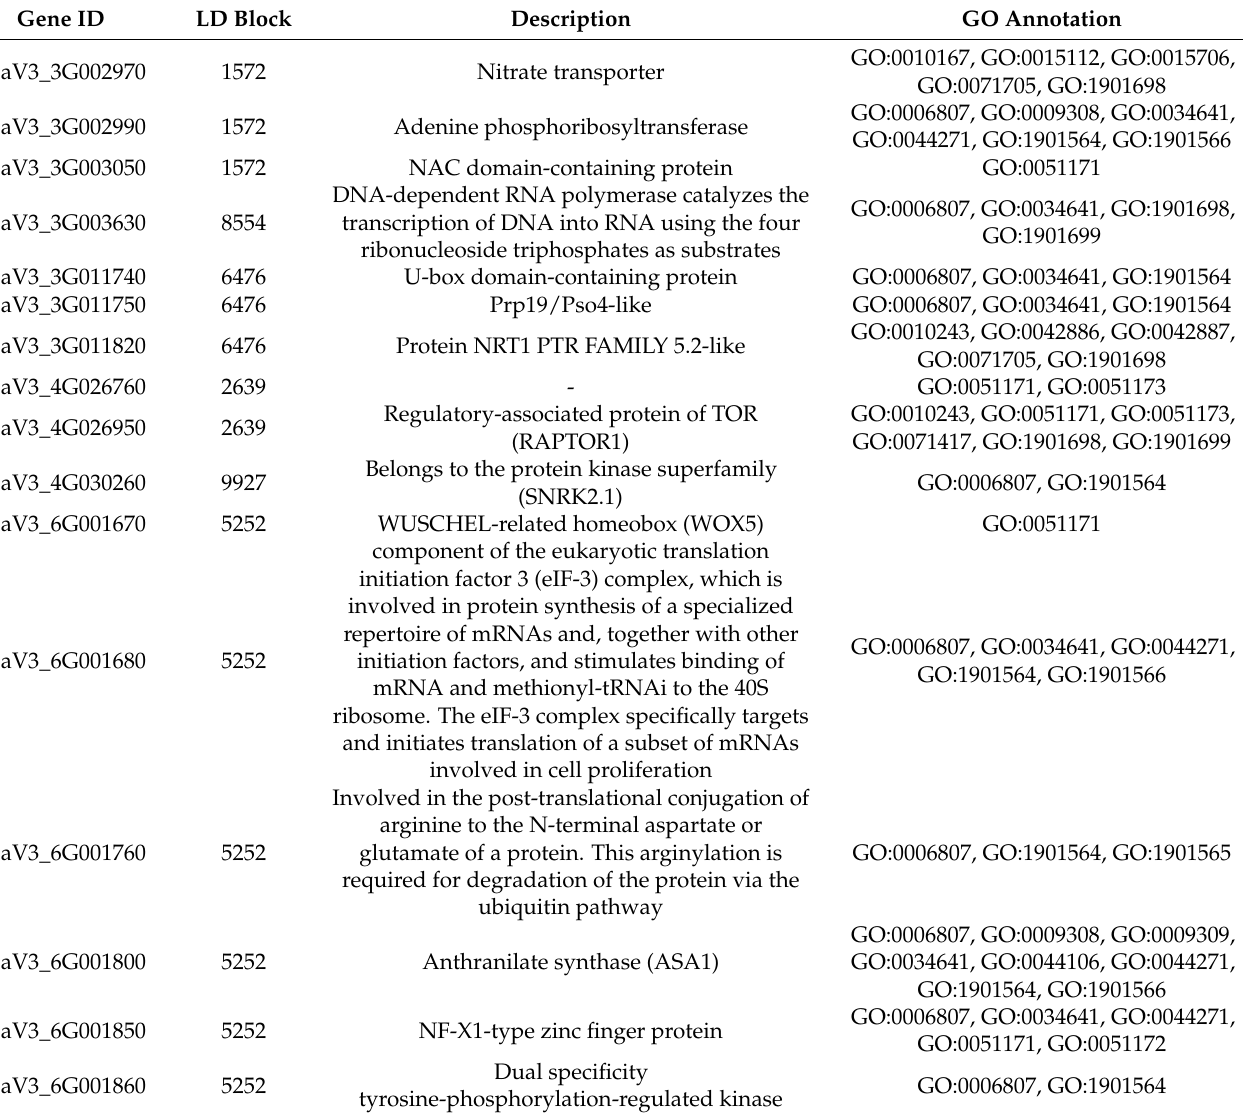
Table 3. Candidate genes by GO